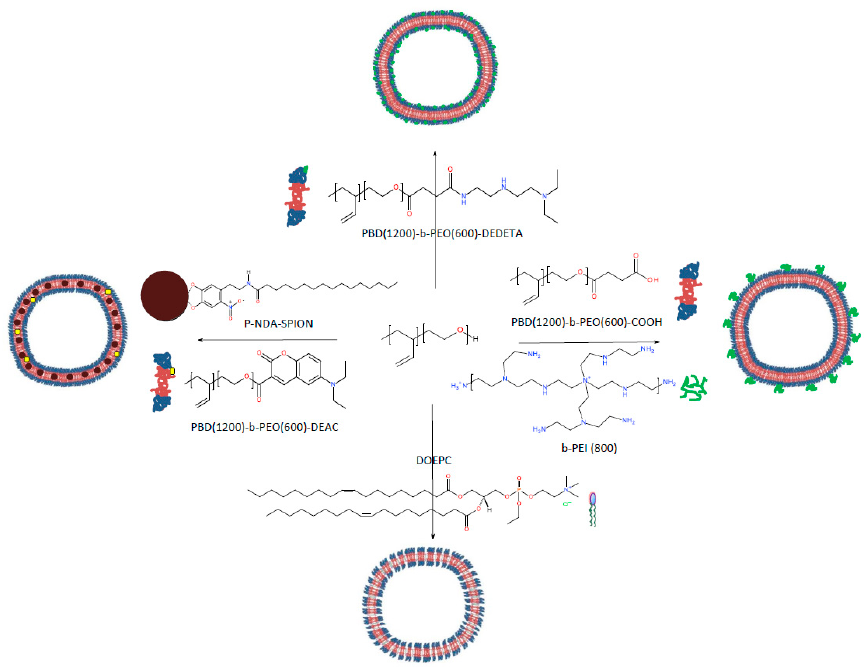
Scheme 1. Polymersome surface modifications to promote cell uptake; each can be combined with integration of SPION in the membrane interior.